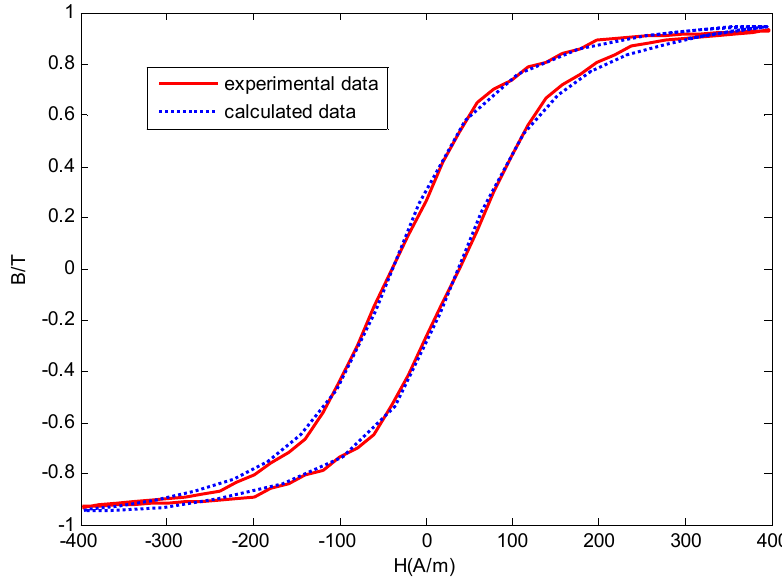
Figure 7. Experimental B-H hysteresis Loop and calculated B-H hysteresis Loop obtained by IBBO.